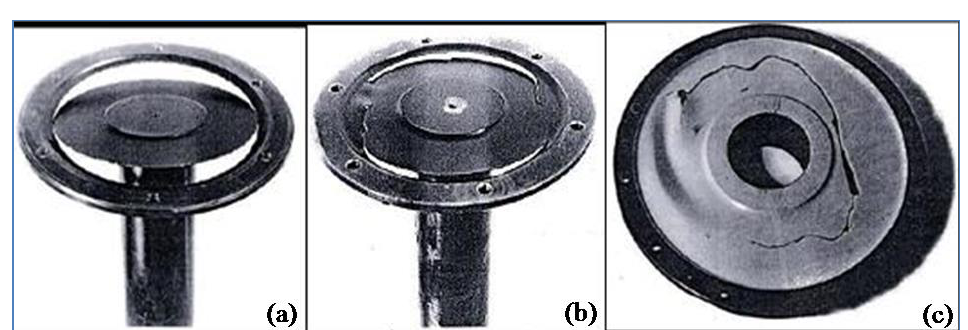
Fig. 2: Various coupling failure types: (a) under zero axial displacement, (b) under angular misalignment and large axial displacement, (c) buckling and and cracking under angular misalignment and large axial displacement.